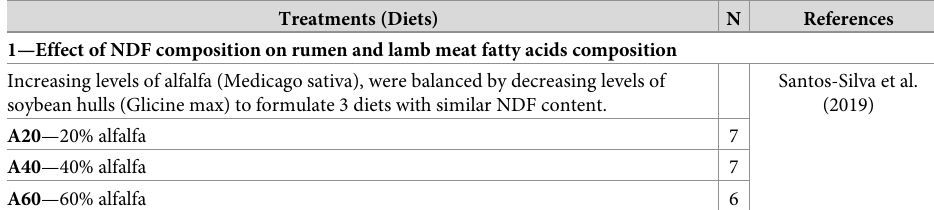
2—Effects of the physical form of alfalfa and the level of replacement in the diets of cereals by agro-industrial by-products on rumen and lamb meat fatty acid composition Eight diets with a forage:concentrate ratio of 40:60 were formulated in a 2 × 4 factorial arrangement of treatments considering forage particle size and cereal replacement by Low Starch by-Products.